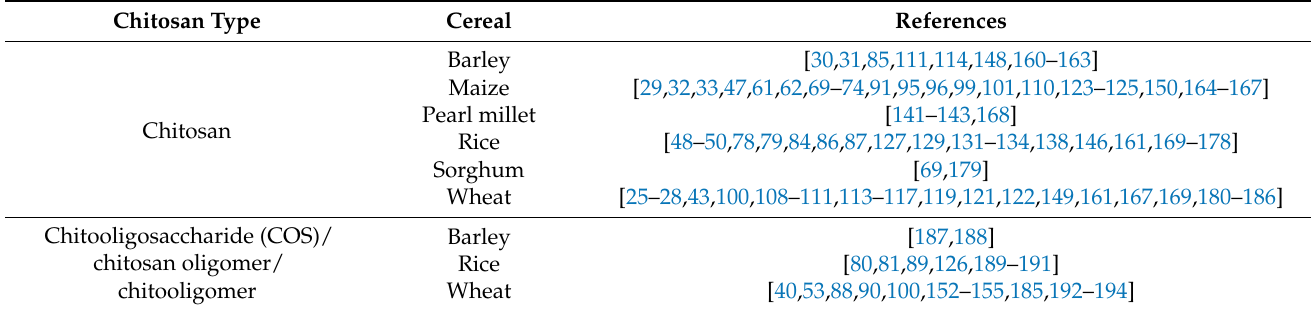
Table 1. Summary of papers on chitosan, its derivatives and cereals published since 2000. Chitosan